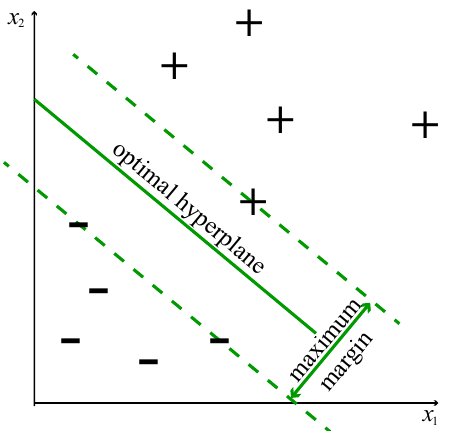
Figure 3. Linear support vector machine (SVM) in a two-dimensional